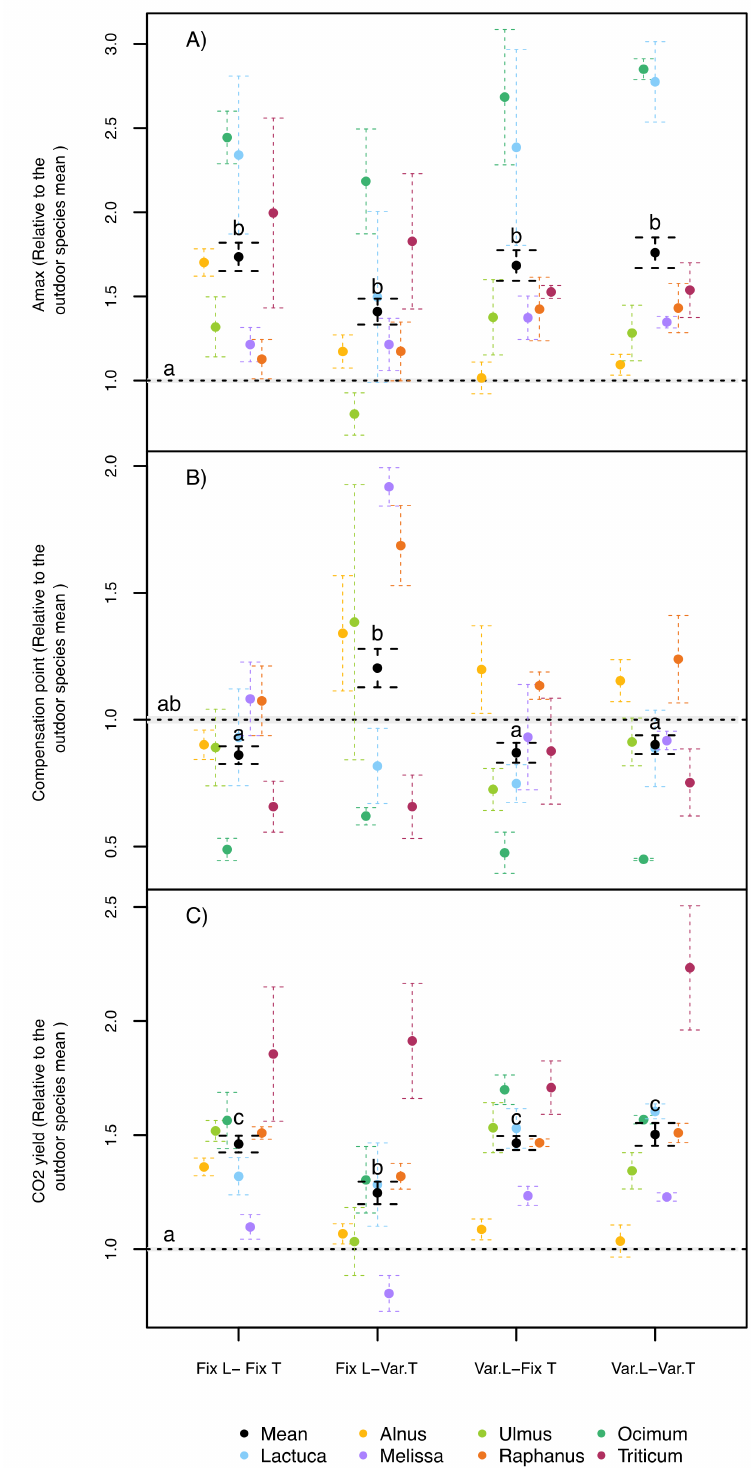
Figure 4. ( A ) Maximum photosynthesis (A max ), ( B ) light compensation point of photosynthesis (CP), and ( C ) photosynthetic CO 2 yield of seven different species normalized to an outdoor control treatment under four treatment combinations (fixed, Fix., or variable, Var.) of two environmental factors (light, L, and air temperature and humidity, T). Amax and CP were measured under a standard light source (70%R (red) and 30%B (blue)). Error bars correspond to the standard error. N = 3 for each species, where N for the average = 21. Different letters indicate significant differences ( p < 0.05, by Tukey post hoc tests) among treatments (including the outdoor trials) using species as random